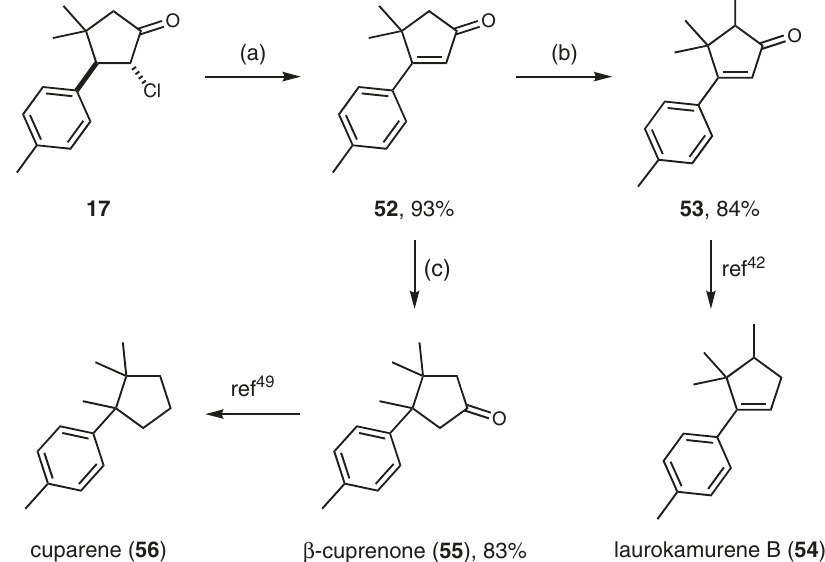
Fig. 3 | Synthetic applications. Reaction conditions: a 17 , K 2 CO 3 , DMF, 80°C; b 52 , LiHMDS, MeI, THF, − 78°C to RT; c 52 , Ni(acac) 2 , AlMe 3 , THF, RT. LiHMDS lithium bis(trimethylsilyl)amide.